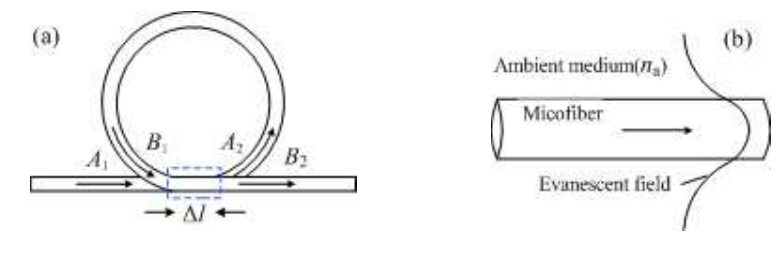
Figure 1. (a) Geometry of of an MLR and (b) Optical signal transmits in a microfiber with the ambient